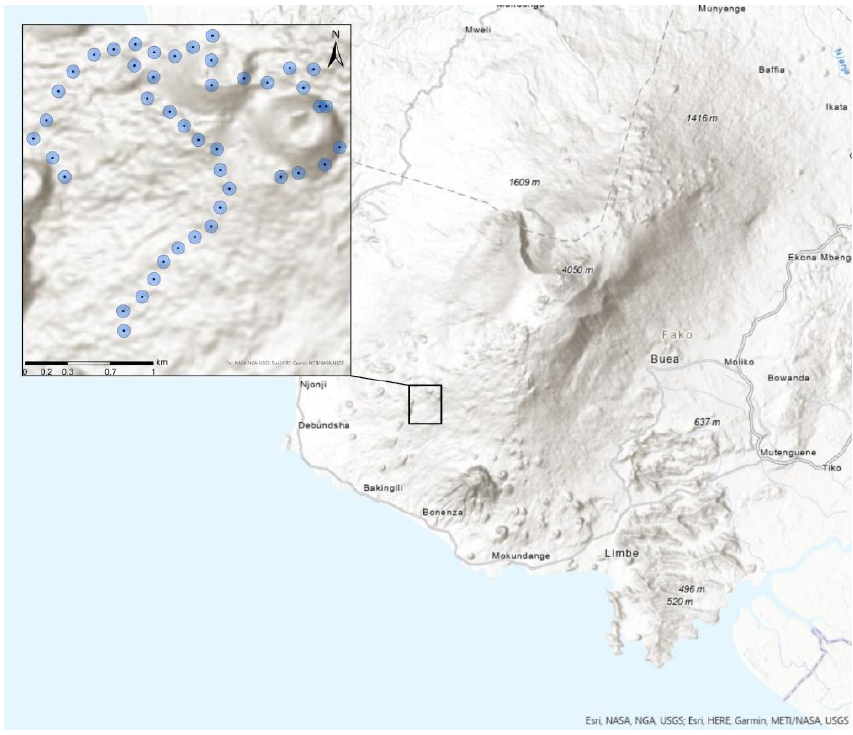
Figure 1. Map of the study area with positions of bird count points (ESRI hillshade basemap was used to create the figure).